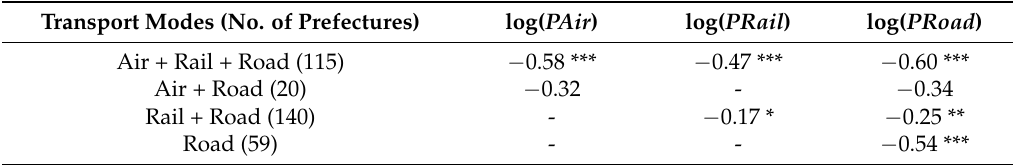
Table 2. Pearson correlation coefficients between arrival days and log-transformed passenger volumes by transport modes in 334